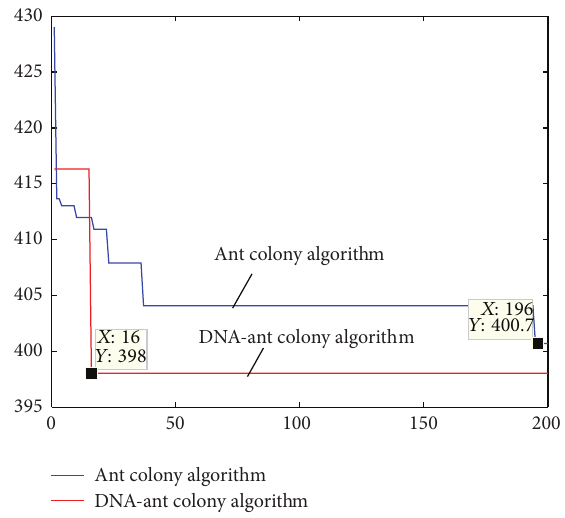
Figure 7: Distribution cost optimization curve (top or good air pol- lution